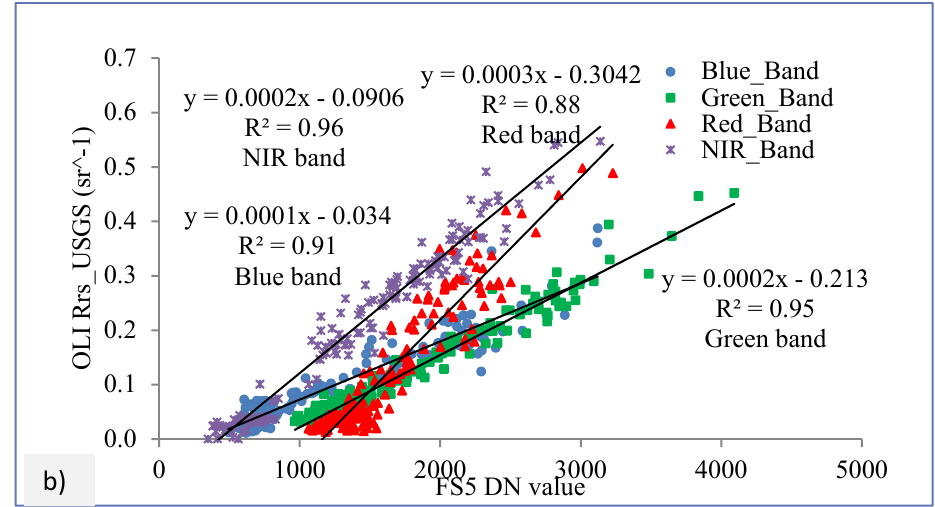
Figure 5. Linear regression was used to convert the DN to Rrs values; ( a ) Rrs FLAASH and ( b ) Rrs USGS .